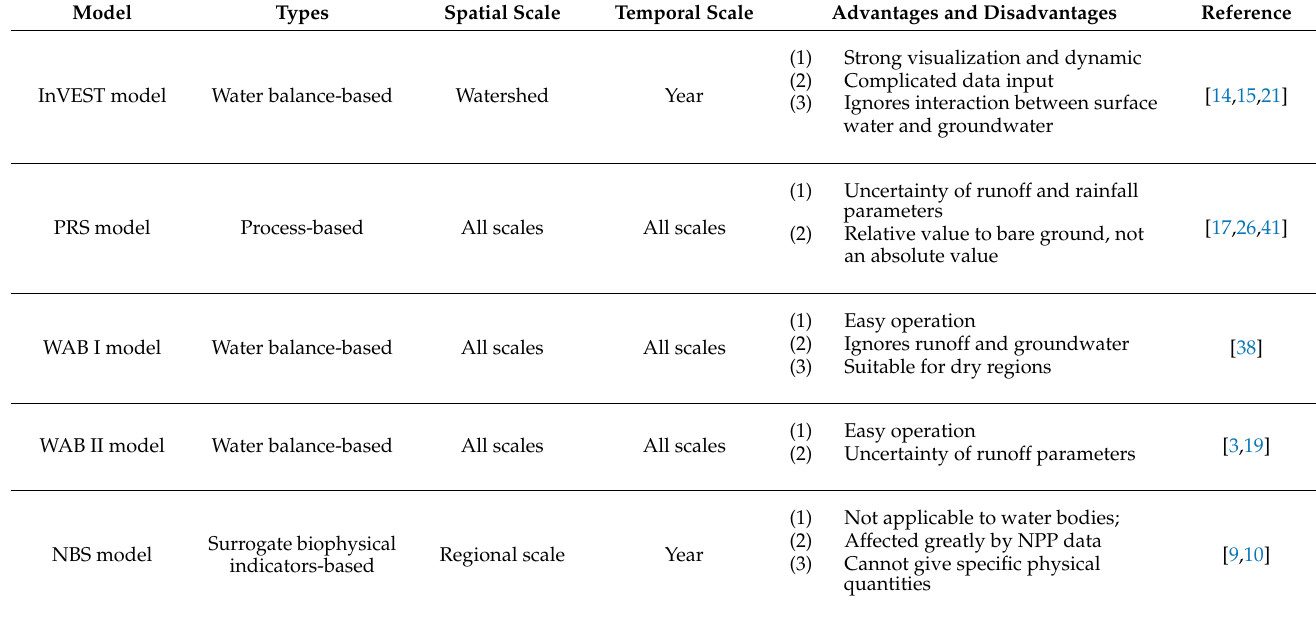
Table 2. Basic characteristics of the five selected